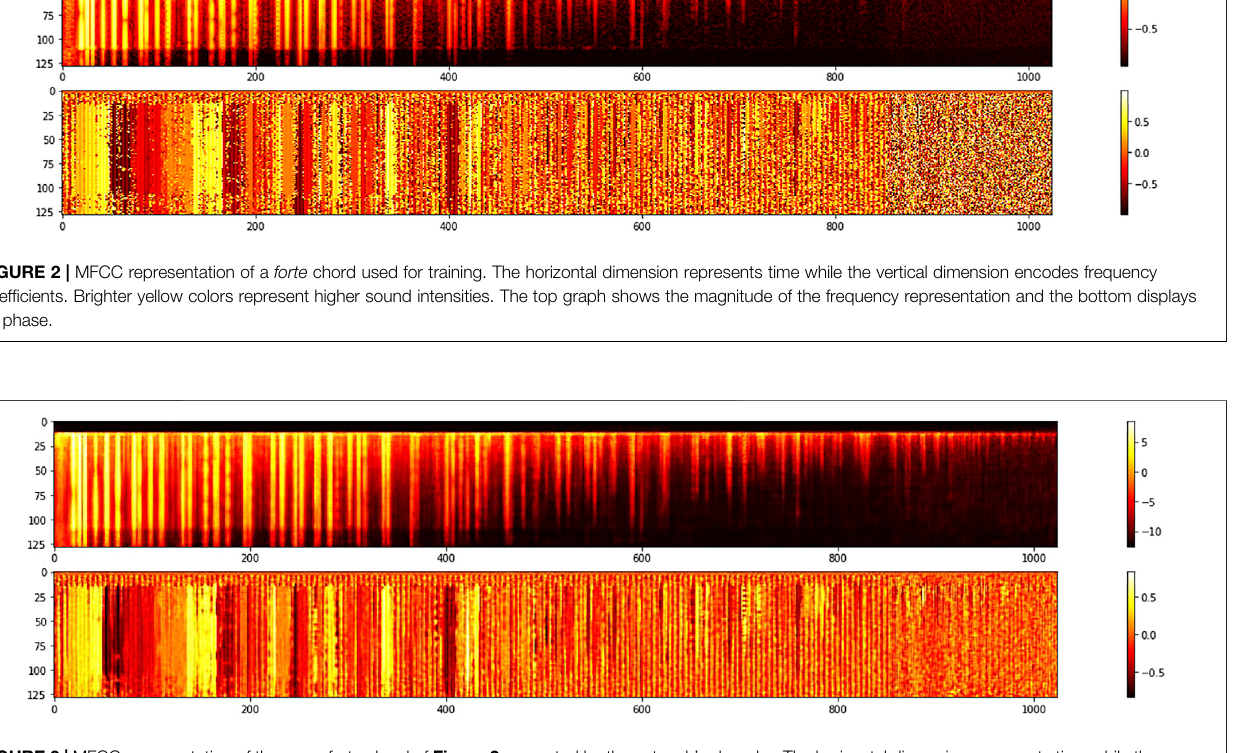
FIGURE 3 | MFCC representation of the same forte chord of Figure 2 generated by the network ’ s decoder. The horizontal dimension represents time while the vertical dimension encodes frequency coef fi cients. Brighter yellow colors represent higher sound intensities. The top graph shows the magnitude of the frequency representation and the bottom displays its